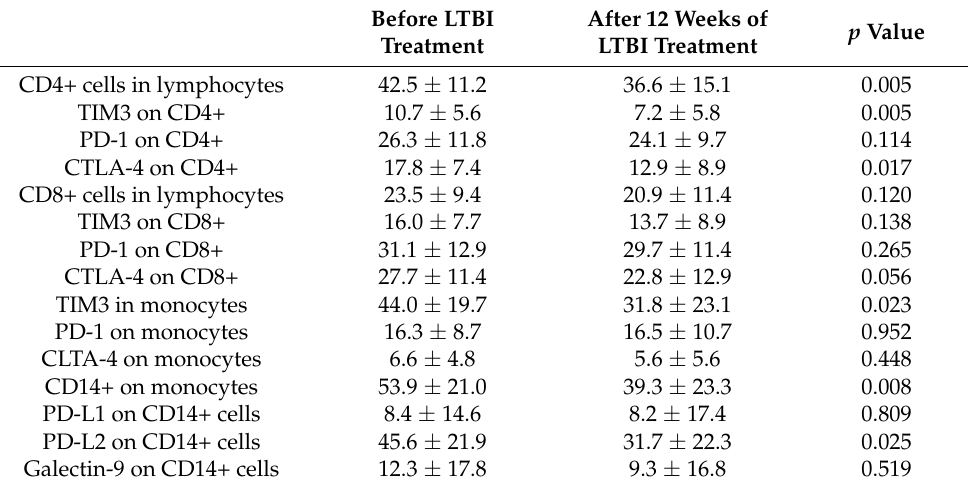
Abbreviations: CTLA-4, cytotoxic T-lymphocyte-associated protein 4; LTBI, latent tuberculosis infection; PD- 1, programmed death-1, TIM3, T cell immunoglobulin mucin domain-containing-3. Data are presented as mean ± standard